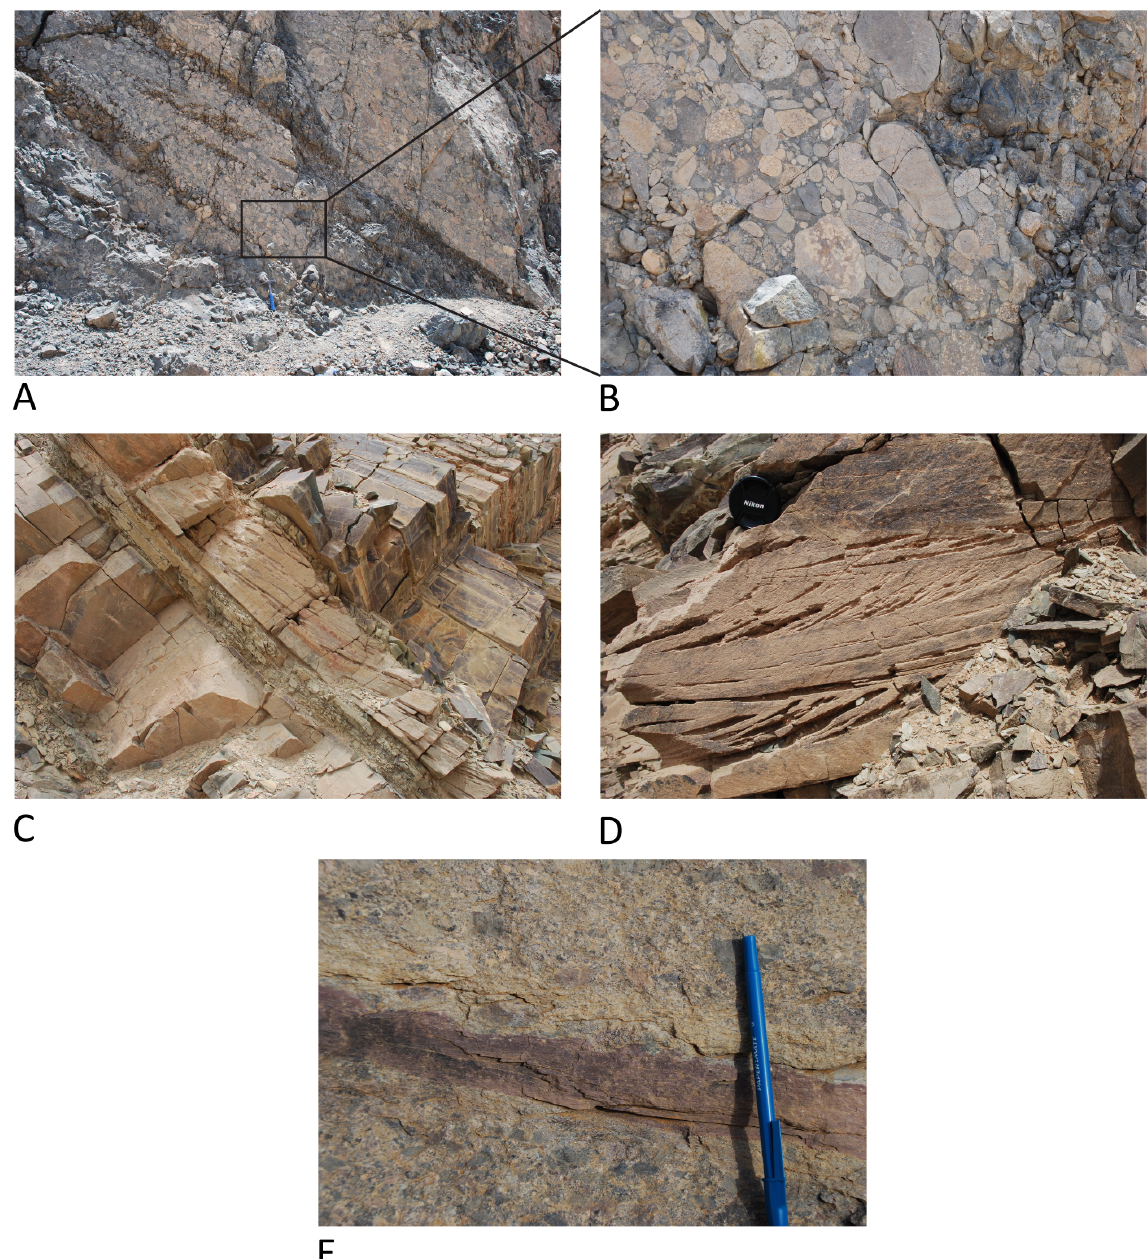
Figure 14. Sedimentary features of the Zaydi formation, Murdama group close to the base of the group at the northern margin of the Maslum basin at Umrah. ( A ) Cobble to boulder, clast-supported polymict conglomerate in beds 1–1.5 m thick; ( B ) Close-up of conglomerate outlined by the box in A, showing the well rounded character of the clasts; ( C ) Planar, tabular set of curved foreset cross beds, ~10 cm thick, interbedded with medium-bedded sandstone below and thin-bedded sandstone above. The cross-bed set is immediately underlain by a bed of fine-grained sandstone to siltstone; ( D ) Slightly channeled sets of cross beds in medium-grained sandstone; ( E ) Thin bed (~5 cm thick) of siltstone interbedded with pebble conglomerate. This type of siltstone is the source for intraformational clasts observed in rip-up conglomerate in the Zaydi formation (see Figure